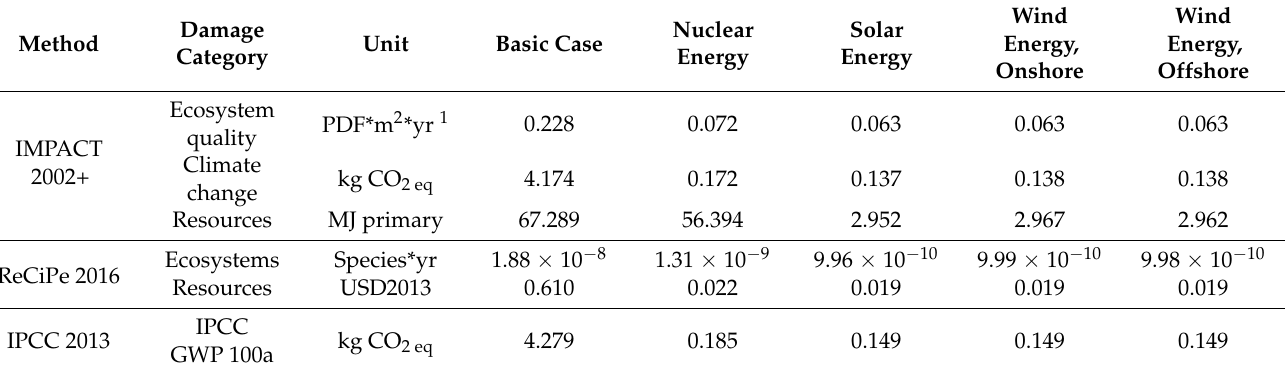
Table 11. Summary of impact assessment results for RO used with different energy sources.